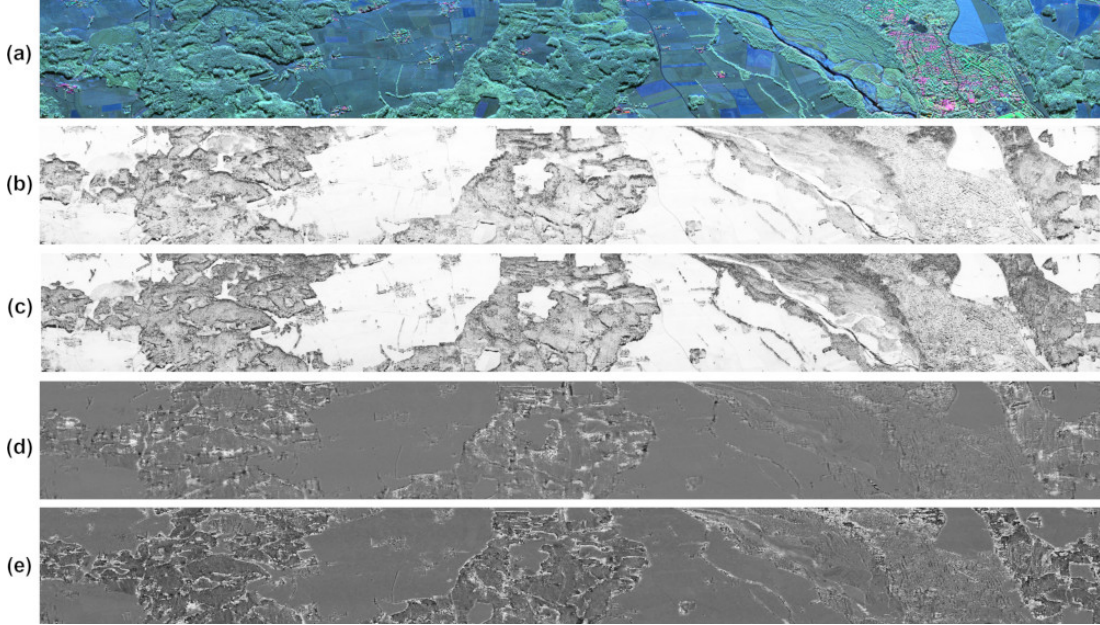
Figure 11. ( a ) X-band polarimetric SAR image in Pauli basis with Tx and Rx on X1 antenna; ( b , c ) coherence of HH polarization in full-baseline and half-baseline mode; and ( d , e ) residual phase in full-baseline and half-baseline